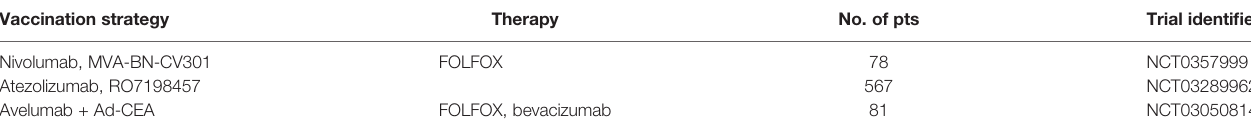
TABLE 1 | Current clinical studies of vaccines combined with ICIs. Vaccination strategy Therapy No. of